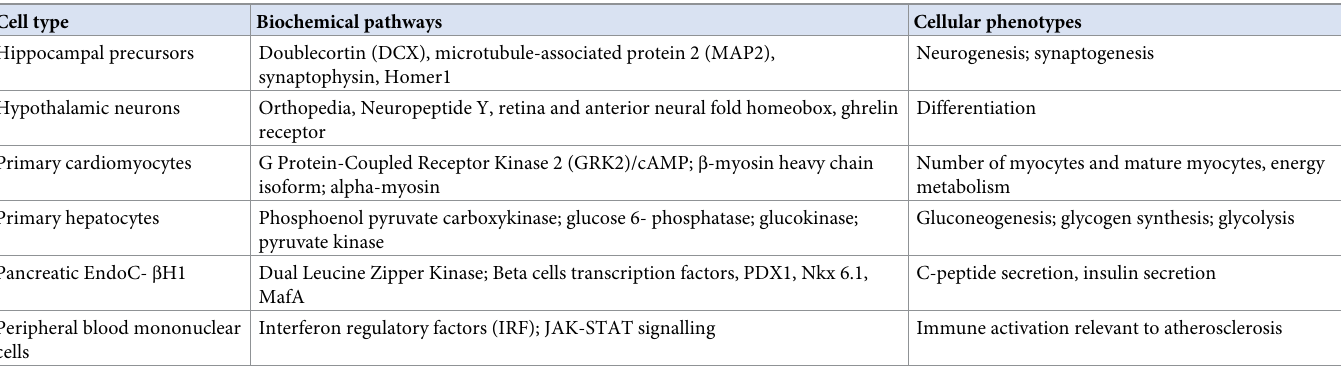
Table 3. Biochemical and cellular candidate pathways that will be investigated in